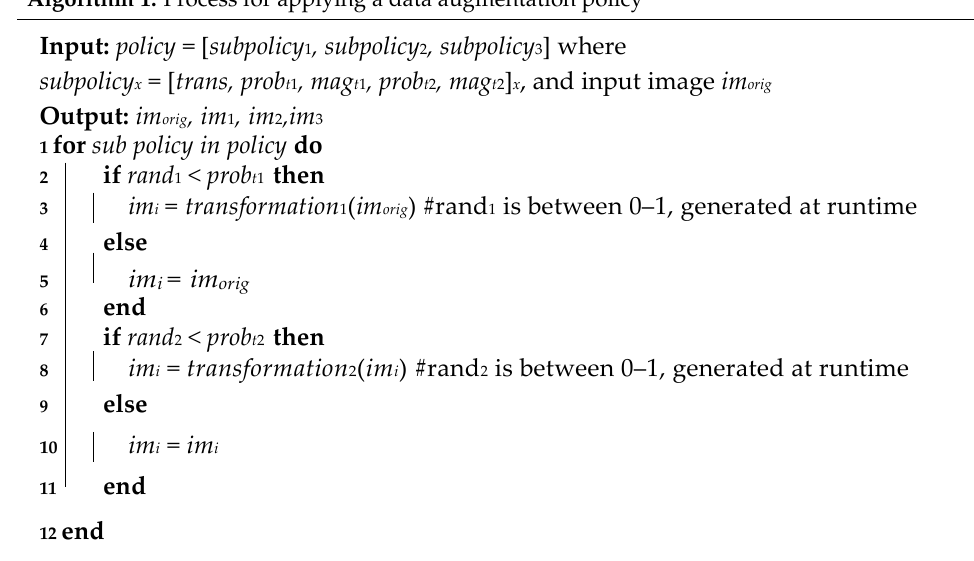
Algorithm 1: Process for applying a data augmentation policy